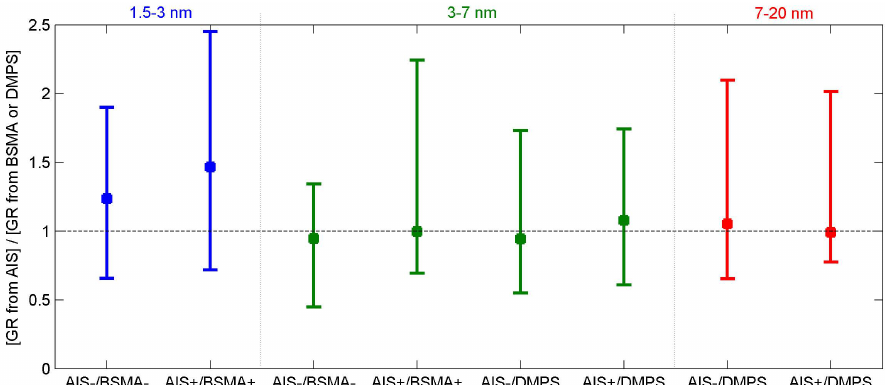
Fig. 4. Ratios of GR values determined from measurements with different instruments for three size ranges. The squares represent the median value of the ratios for the size ranges (the growth rate obtained from AIS divided by the growth rate obtained from BSMA or DMPS). The whiskers represent the 10th and 90th percentiles. Size ranges are marked above the